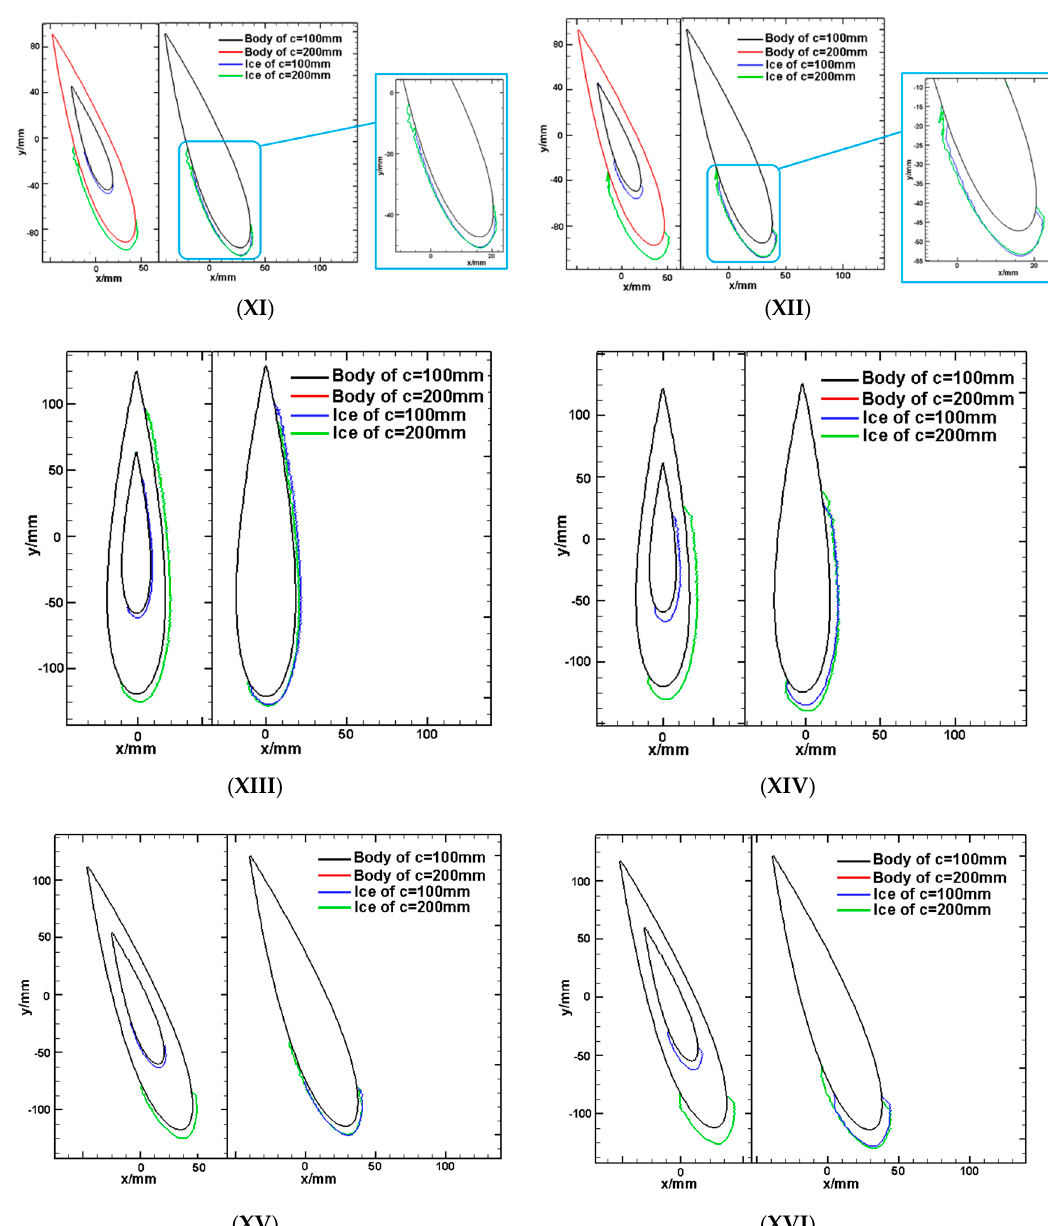
Figure 8. Normalization of icing shape comparison under different conditions: ( I ) ~ ( XVI ) express No.1 condition ~ No.16 condition